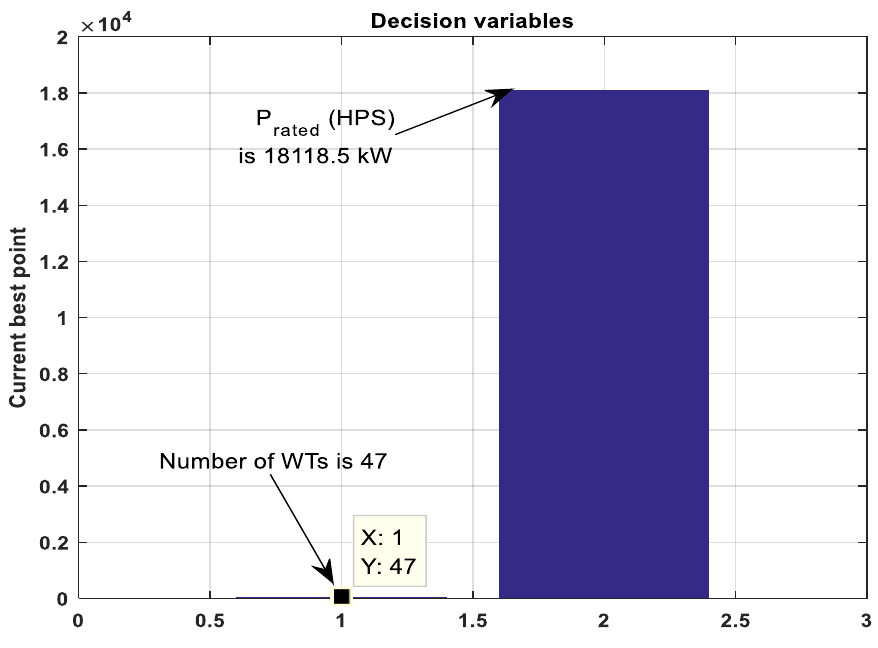
Figure 7. Corresponding decision variables of the optimal configuration.